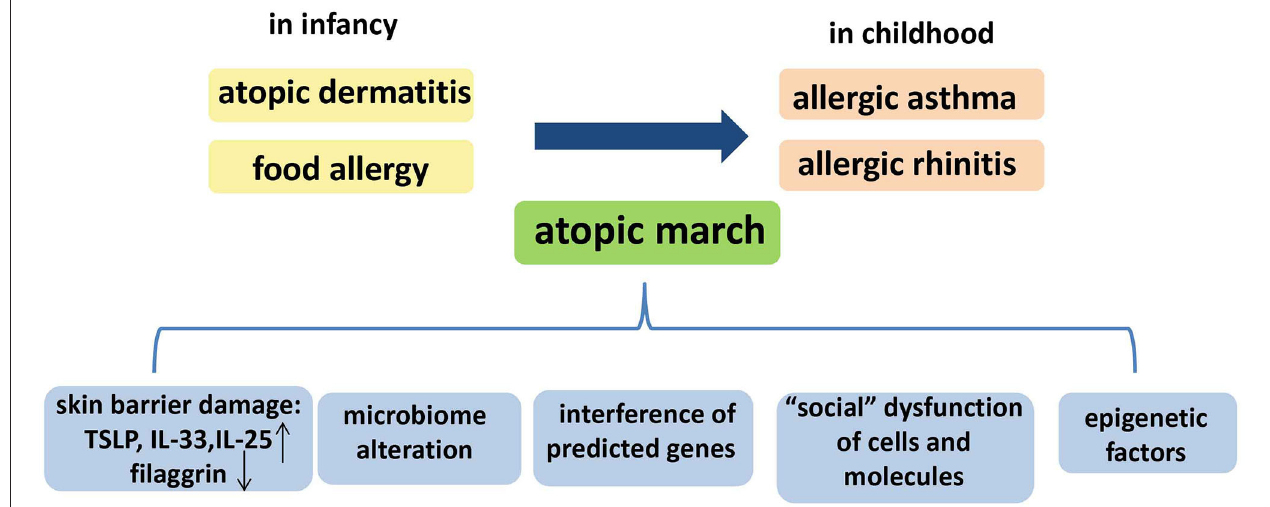
FIGURE 2 | The temporal pattern and the possible mechanisms of the atopic march. The temporal pattern of the atopic march is, in general, from atopic dermatitis (AD) and food allergy in infancy to gradual development into allergic asthma (AA) and allergic rhinitis (AR) in childhood. Several mechanisms could underlie the atopic march: skin barrier damage, microbiome alteration, “social” dysfunction of cells and molecules, epigenetic factors, and interference of other predicted